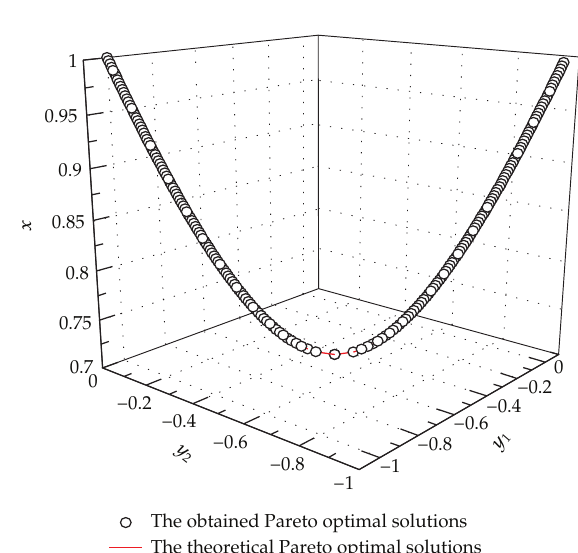
Table 2: Results of the Generation Distance (cid:2) GD (cid:3) and Spacing (cid:2) SP (cid:3) metrics for Examples 4.1 and 4.2. Example GD SP Example 4.1 Example 4.2